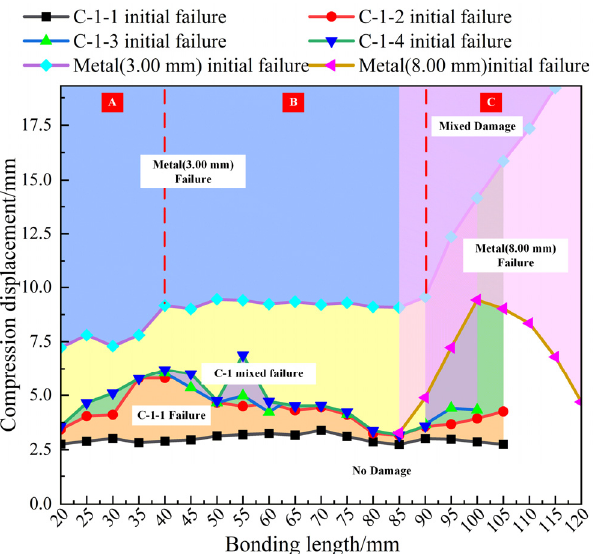
Figure 18. Damage and failure prediction diagram for metal-composite L-joints and Metal